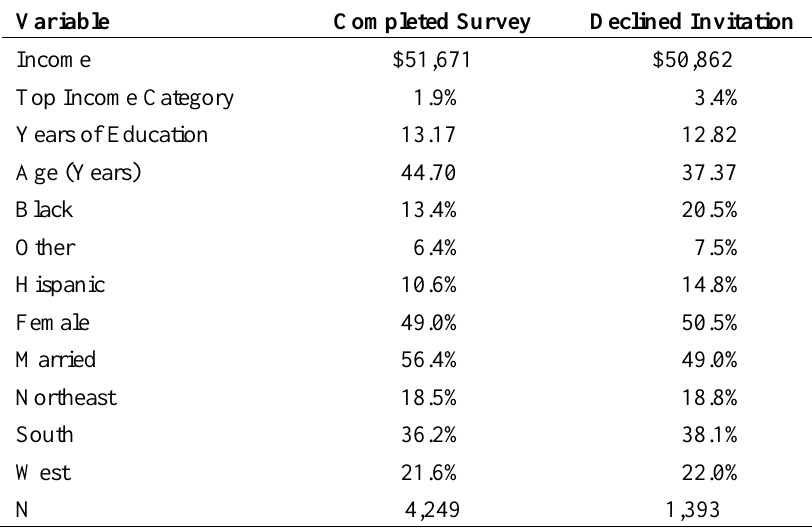
Table 7. Non-response characteristics in Internet